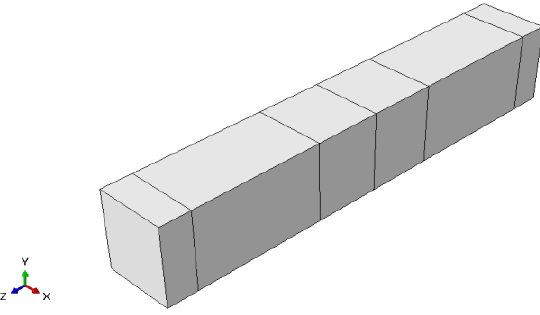
Figure 7. Beam model created for analysis in ABAQUS.